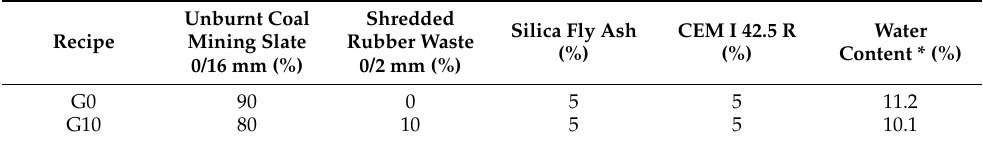
Table 2. The recipes for the mixtures used for the research. Recipe